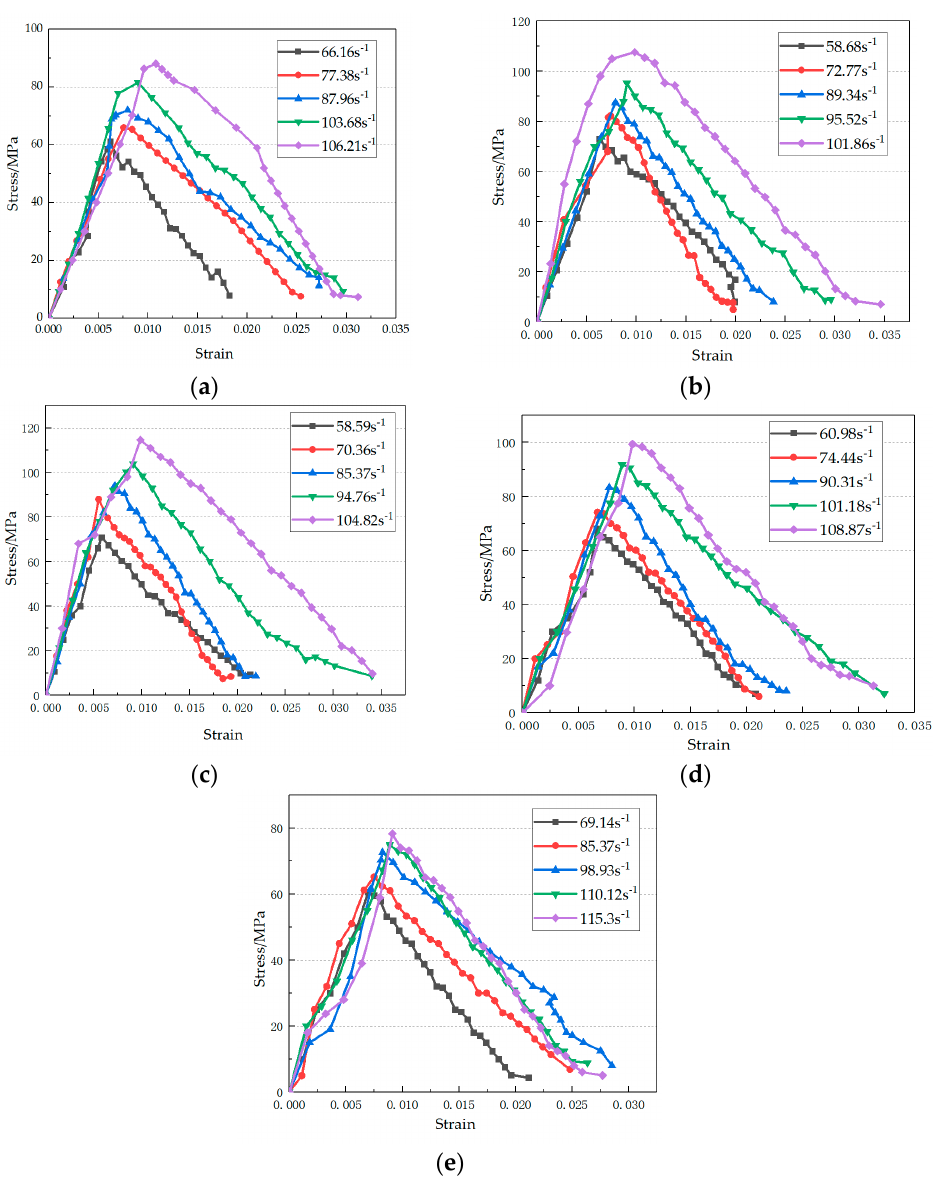
Figure 6. Stress–strain curve under dynamic load ( a ) OA-D-0; ( b ) OA-D-30; ( c ) OA-D-60; ( d ) OA-D-90; ( e )